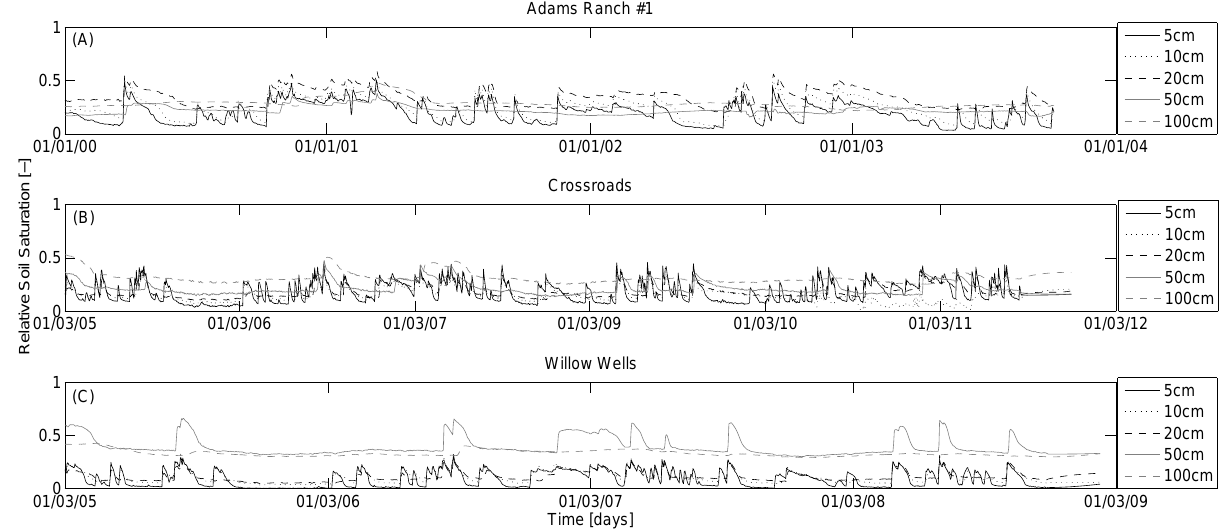
Fig. 5. Time series of the point measurements of the soil relative saturation at the three stations of the SCAN network considered in the present study: Adams Ranch #1 (A) , Crossroads (B) , and Willow Wells (C) in New Mexico, US. Probes provide soil moisture measurements at depths ranging from 5cm down to